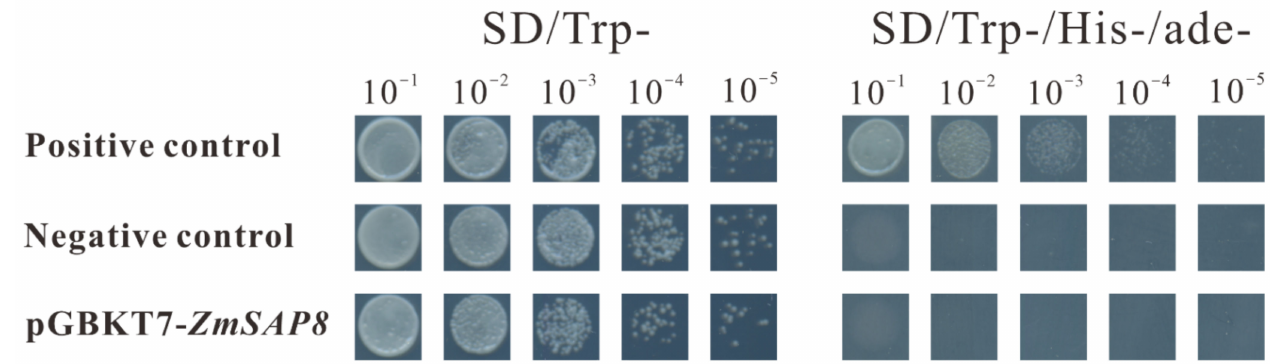
Figure 11. Transcriptional activity analysis of ZmSAP8, BD-p53 and Ad-SV40 large T-antigen were used as positive controls and pGBKT7 empty vector was used as negative